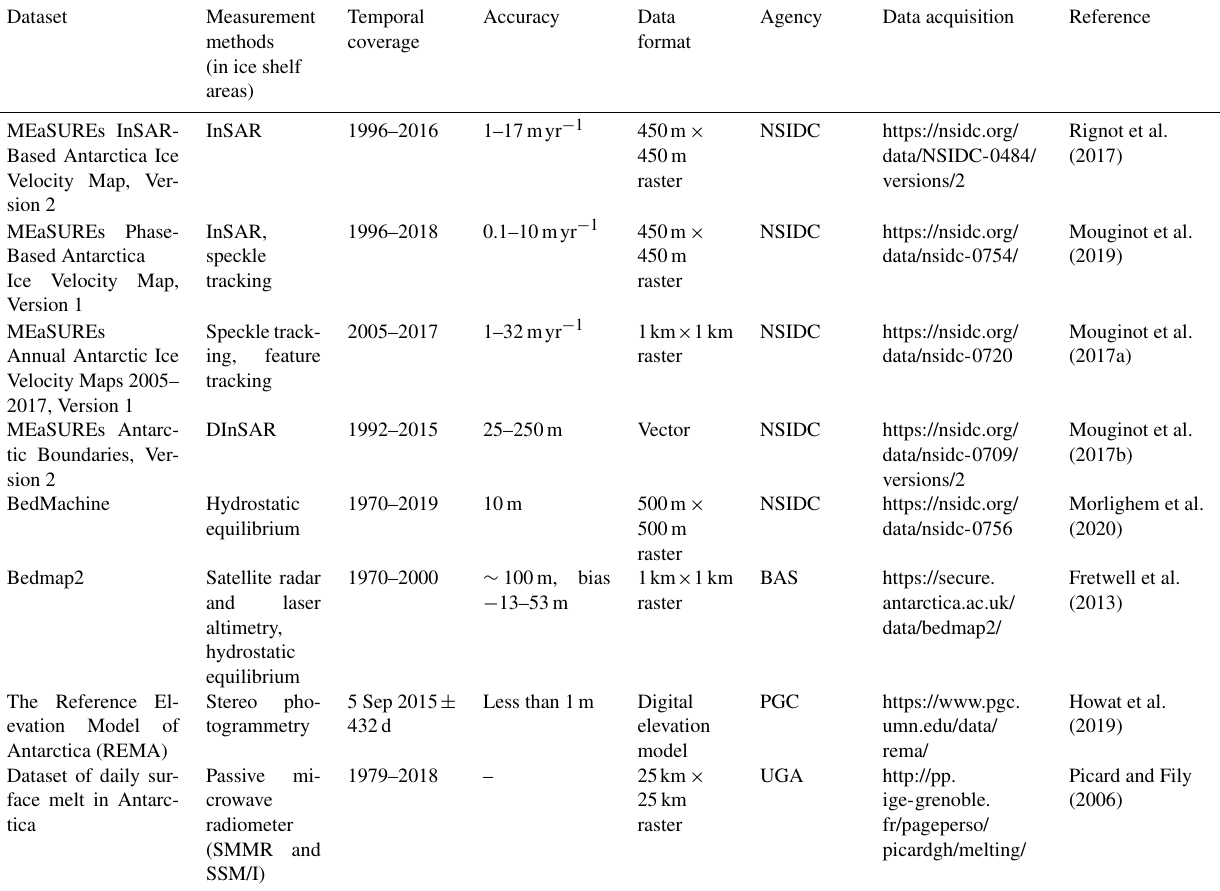
Abbreviations: NSIDC denotes the National Snow and Ice Data Center, BAS denotes the British Antarctic Survey, PGC denotes the Polar Geospatial Center at the University of Minnesota, and UGA denotes the Université Grenoble Alpes.